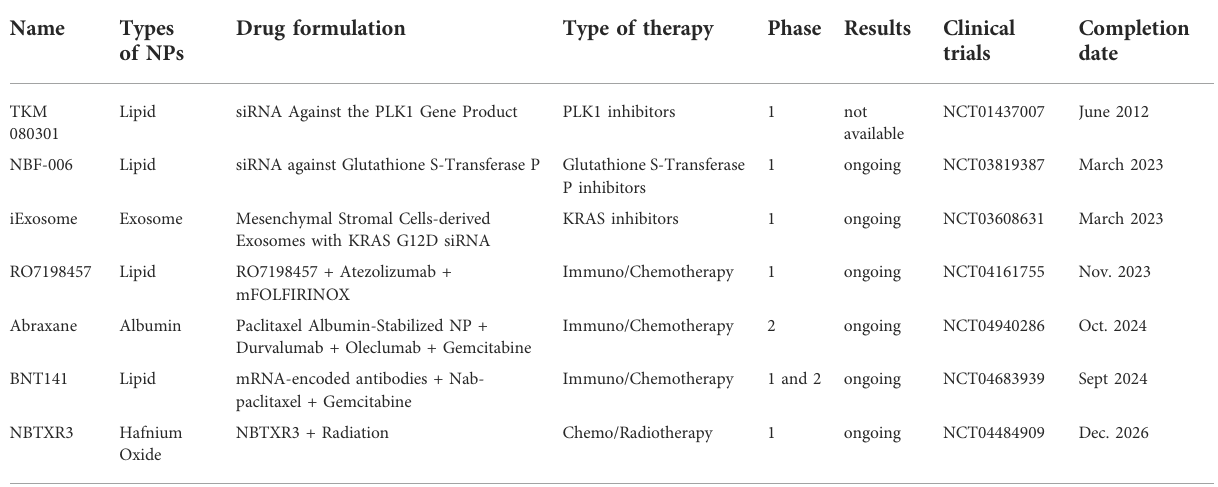
TABLE 3 Clinical trials of different NP-based targeted or combined therapies. Targeted or combined therapies